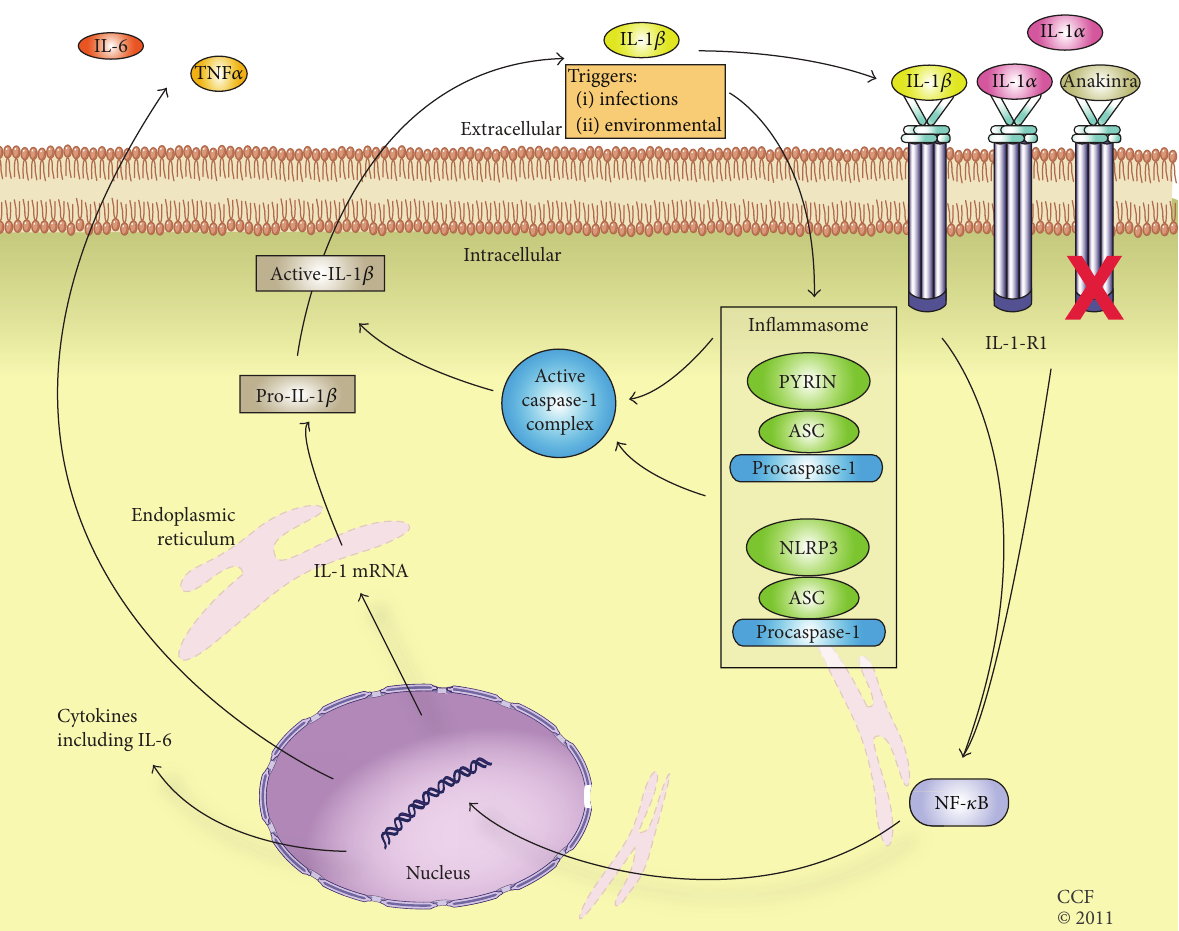
Figure 1: Mechanism of action of anakinra. Both IL-1 𝛼 and IL-1 𝛽 act through IL-1 receptor 1 to stimulate the production of inflammatory cytokines and TNF 𝛼 that lead to the inflammatory cascade. The inflammasome is a complex of distinct proteins which together convert inactive prointerleukin-1 𝛽 to active IL-1 𝛽 . Environmental and infectious triggers can mediate the formation of the inflammasome. Anakinra blocks IL-1 receptor 1, antagonizing the effects of both IL-1 𝛼 and IL-1 𝛽 . ASC: Apoptosis associated speck-like protein containing caspase activation and recruitment domain, IL: interleukin, IL-1-R1: interleukin-1 receptor 1, NF- 𝜅 B: nuclear factor kappa-light-chain-enhancer of activated B cells, NLRP3: NOD-Like Receptor containing pyrin domain